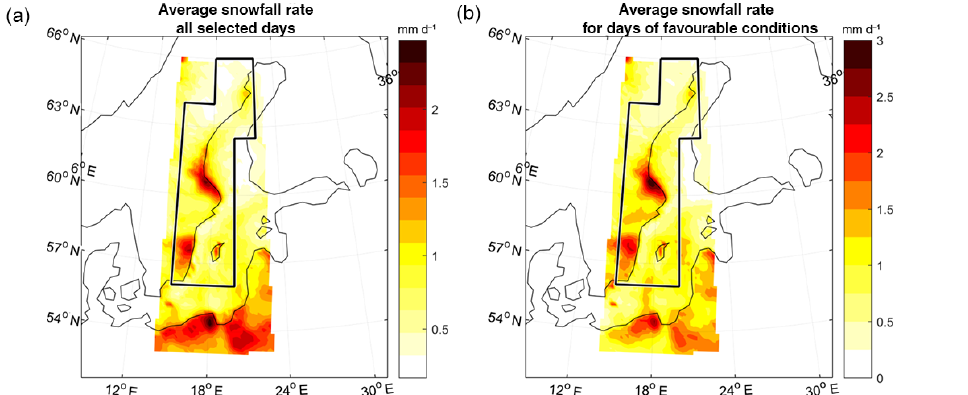
Figure 4. Average snowfall rate for all 121 selected days (a) and for the 49 days of favourable atmospheric conditions for convective snow bands (b) from 2000 to 2010 normalized by the frequency of positive snowfall.